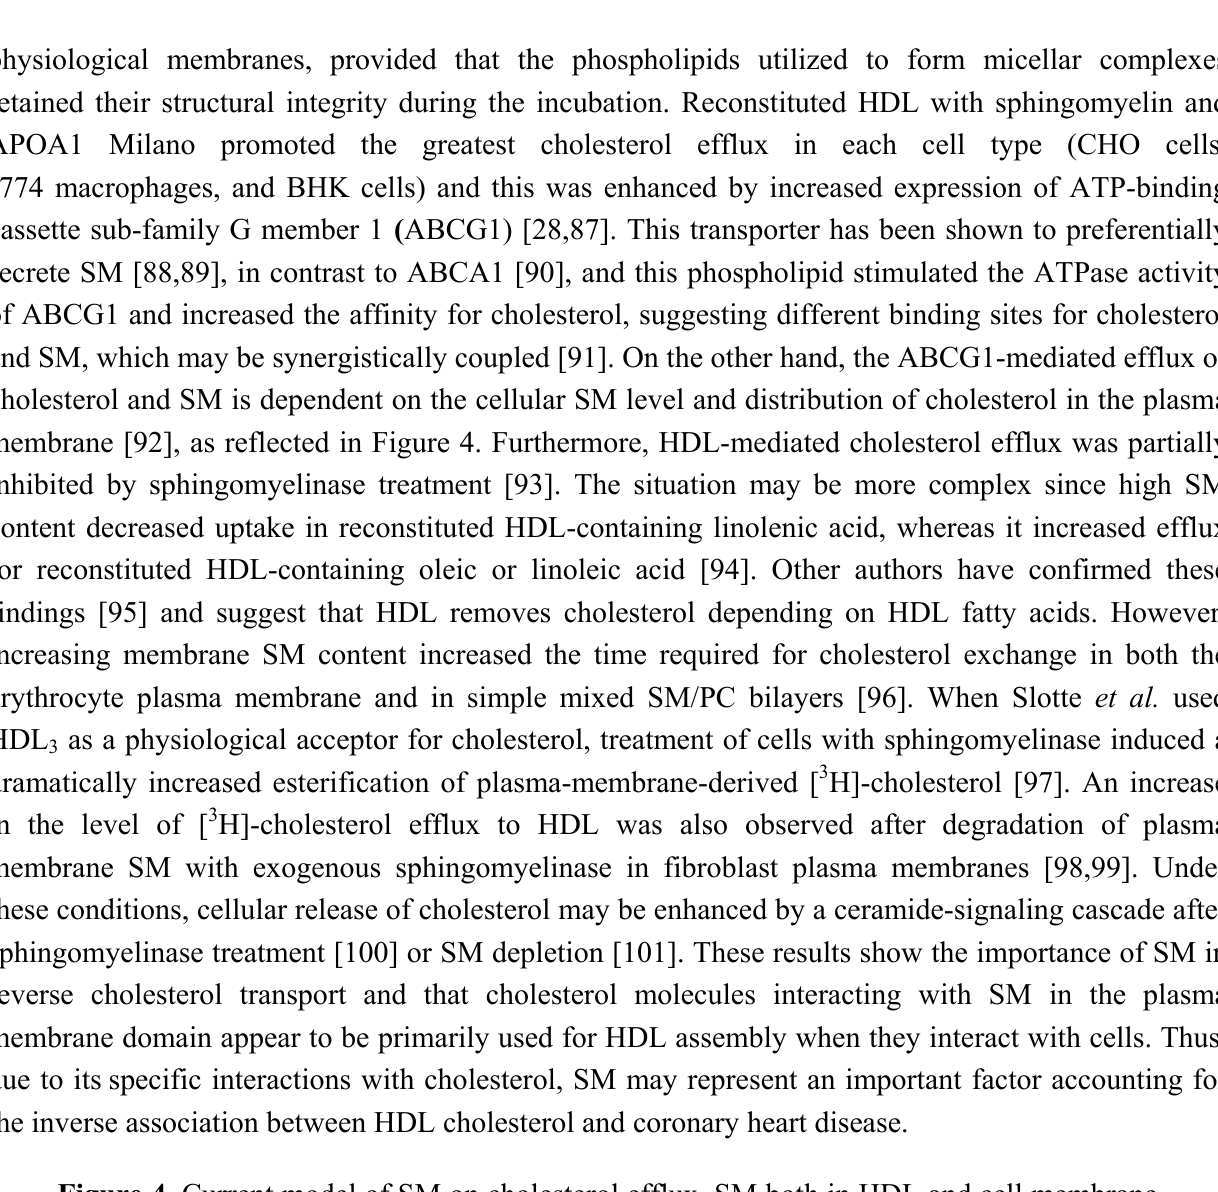
Figure 4. Current model of SM on cholesterol efflux. SM both in HDL and cell membrane regulates ATP binding cassette proteins implicated in reverse cholesterol